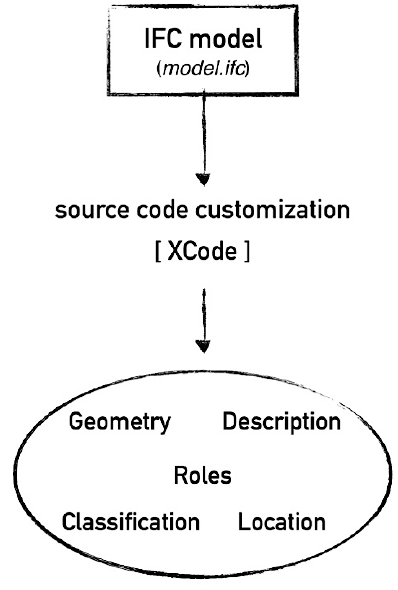
Figure 2. Schema of IFC model customization by using